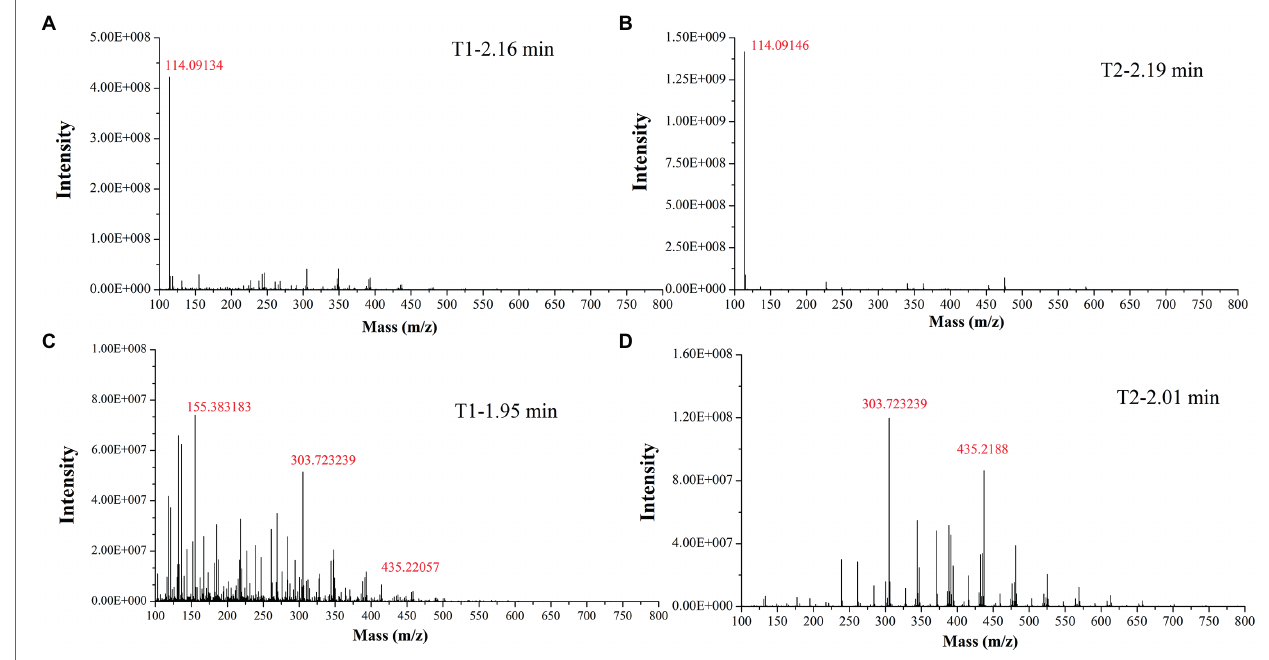
FIGURE 8 | Identification of yellow monascus pigment from WSYMP solution and fermentation broth by UHPLC-ESI-MS.